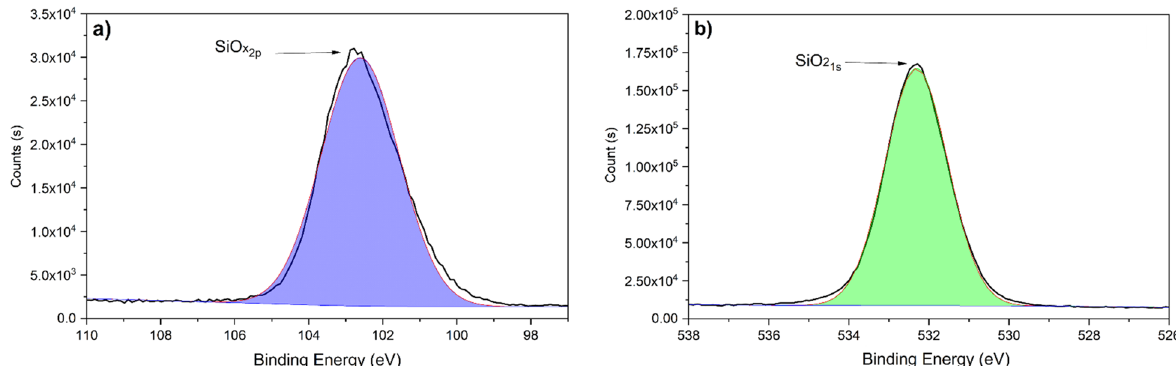
Figure 10. High-resolution XPS spectra of SiO 2 coating by APPJ method ( a ) Si2p and ( b )